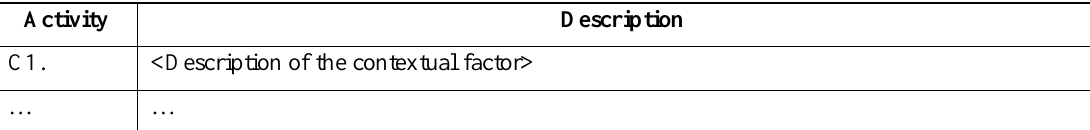
Table 5. Template for documenting contextual